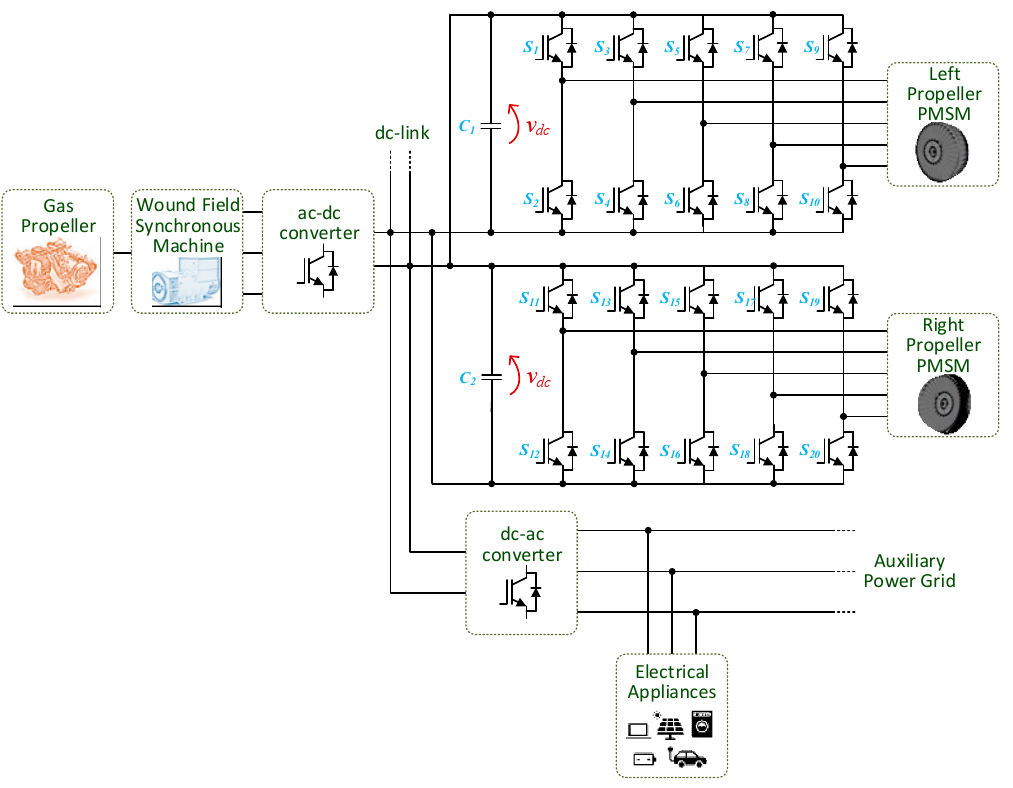
Figure 35. Typical structure of an electric aircraft power system based on two five-phase permanent magnet synchronous machines (PMSMs).